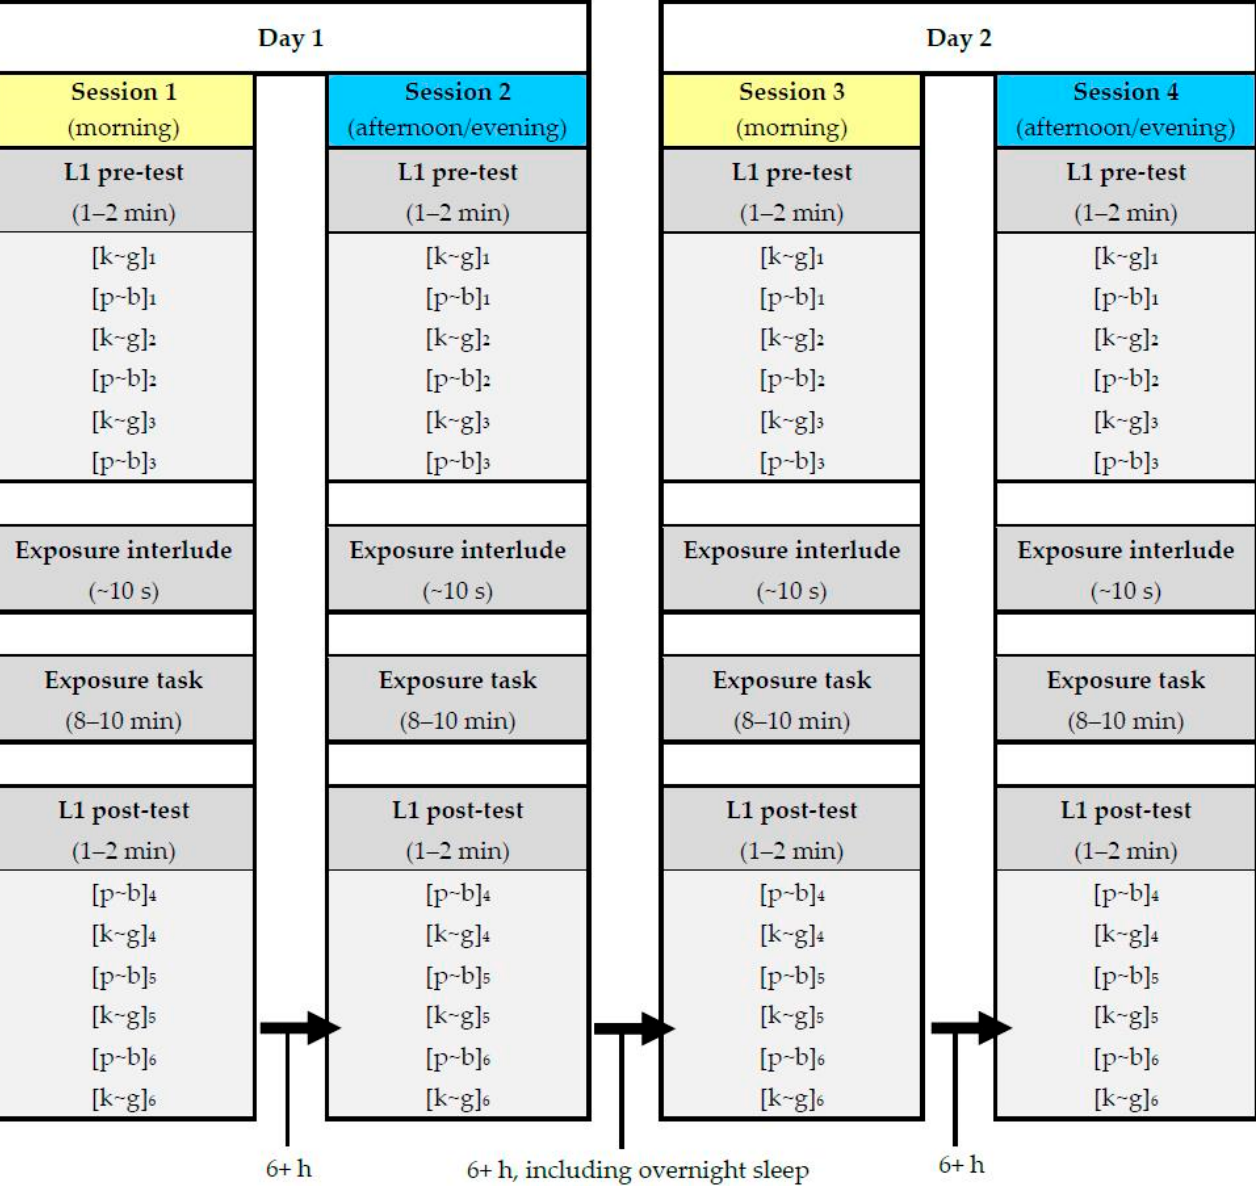
Figure 1. Schematic of the overall study design, showing the first two days of participation (of five total). Acoustically distinct VOT continua for a given place of articulation are denoted by different subscripts.